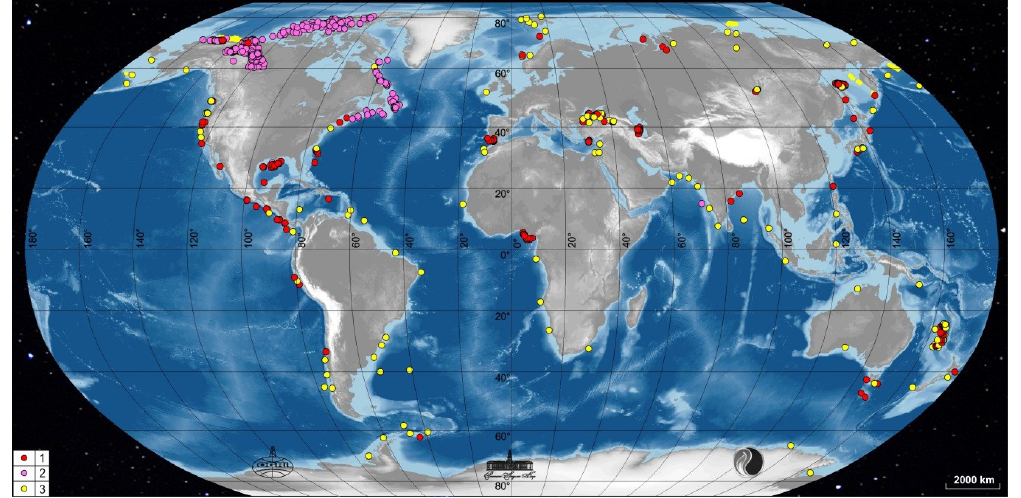
Figure 1. Distribution of gas hydrates in the Arctic and the World Ocean. 1—confirmed by direct studies, including drilling, 2—predicted by log data, 3—predicted by other indirect evidence, including seismic data (BSR).